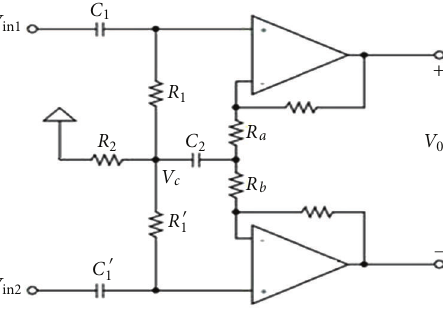
Figure 3: The improved AC-coupled circuit.